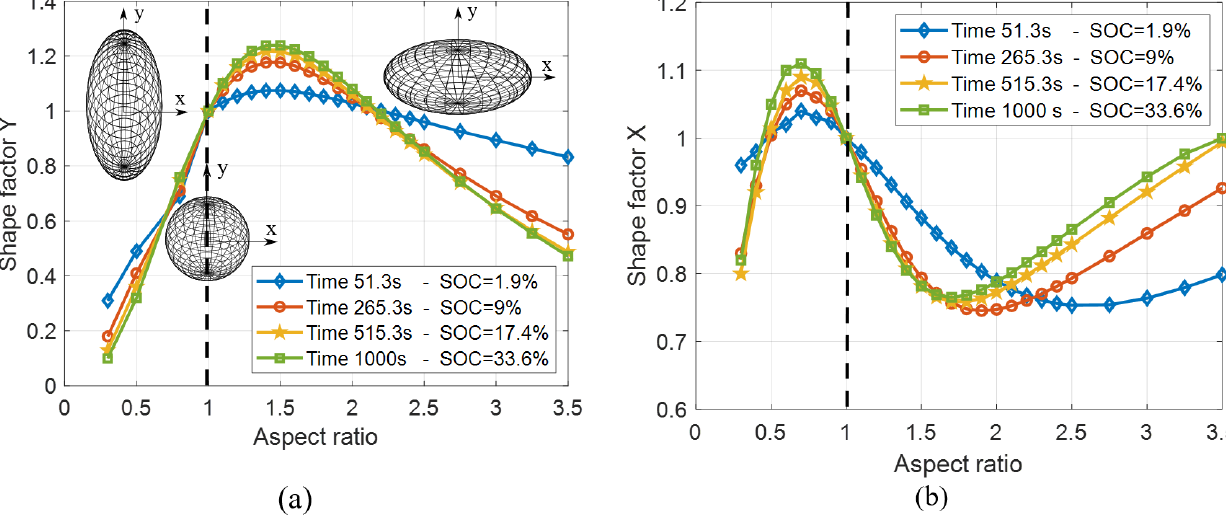
Figure 11. DIS shape factor along y ( a ) and x ( b ) direction with 1 A/m 2 lithium flux. The images of prolate ellipsoid, sphere and oblate ellipsoid, along with coordinate system, belong to the cases α < 1, α = 1 and α > 1 ( a